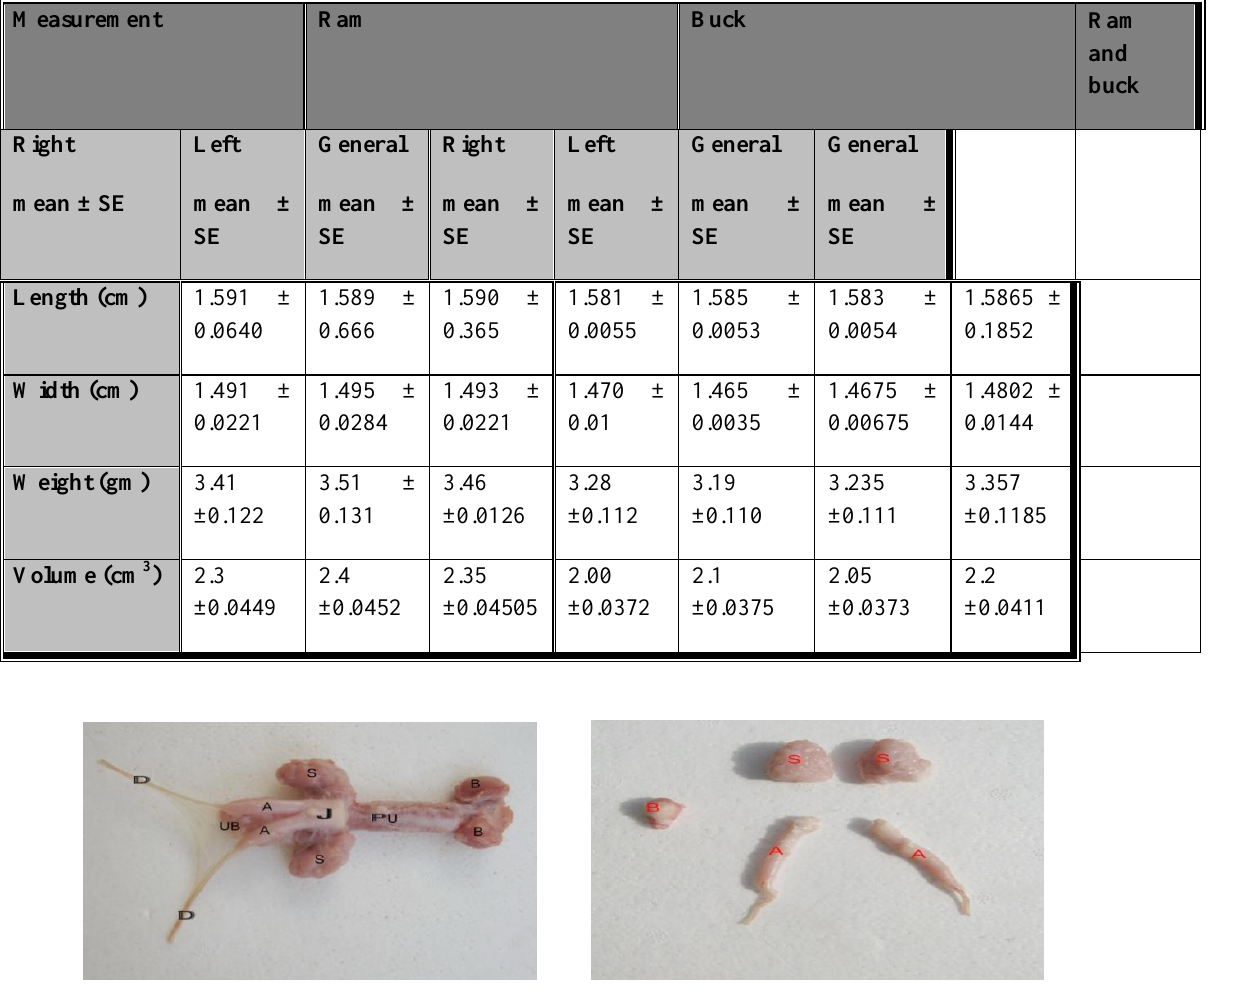
Table 3: Anatomical parameter of bulbourethral gland in ram and buck. Measurement Ram Buck Ram Right